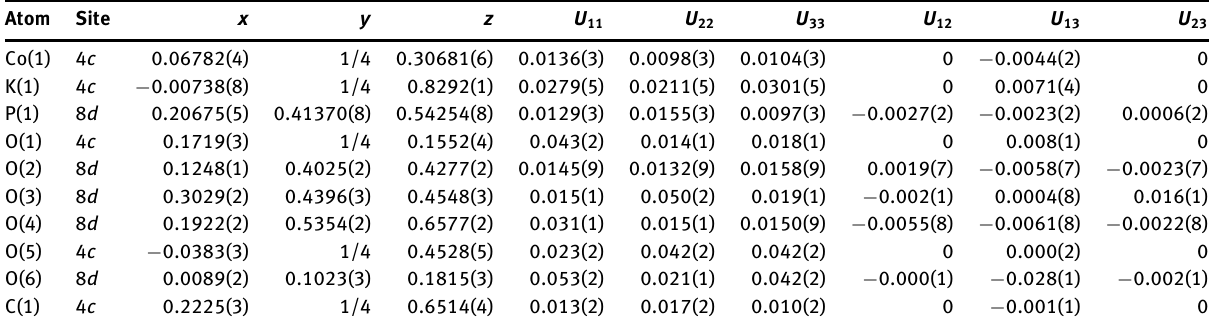
Table 3: Atomic coordinates and displacement parameters (in Å 2